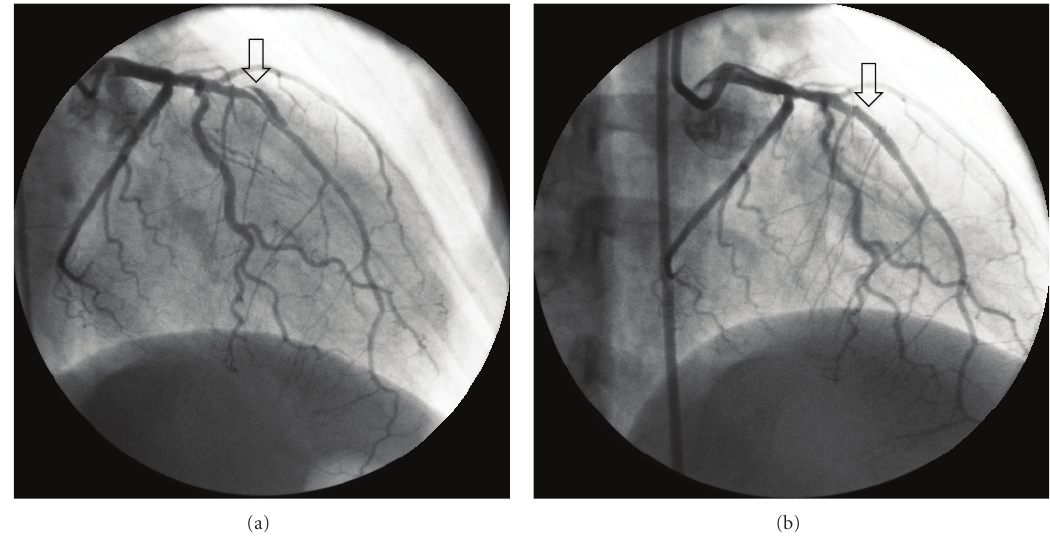
Figure 1: The left anterior descending artery showed spontaneous dissection (arrow). There was a 80% stenosis of the true lumen of the mid-LAD caused by external compression by the hematoma in the false lumen (Figure 1(a)). Bare-metal stent (3 . 0 × 18mm) (arrow) showed in the left anterior descending artery (Figure